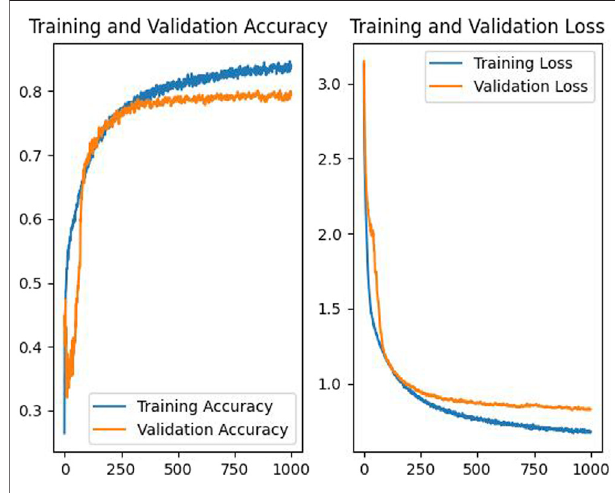
FIGURE 4 | Training process.